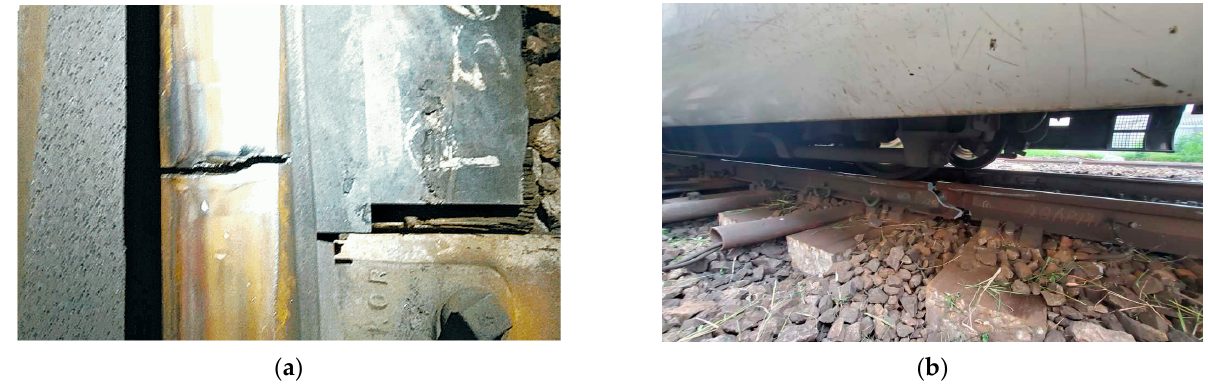
Figure 1. On-site photos taken on the East Rail Line: ( a ) crack on the rail near Fo Tan Station in 2017; ( b ) crack on the rail near Hung Hom Station in 2019.